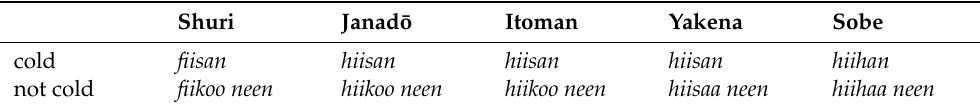
Table 4. The negation of adjectives in different Okinawan